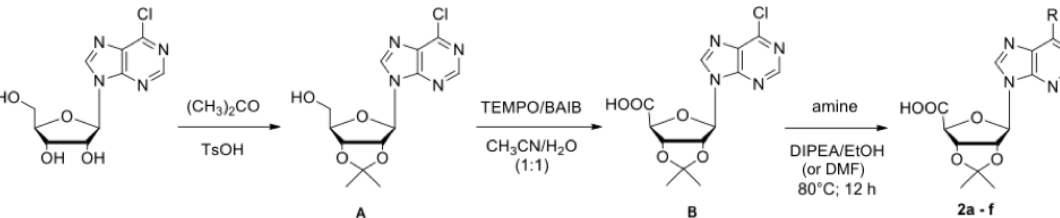
Figure 7. General synthesis steps of series 2.